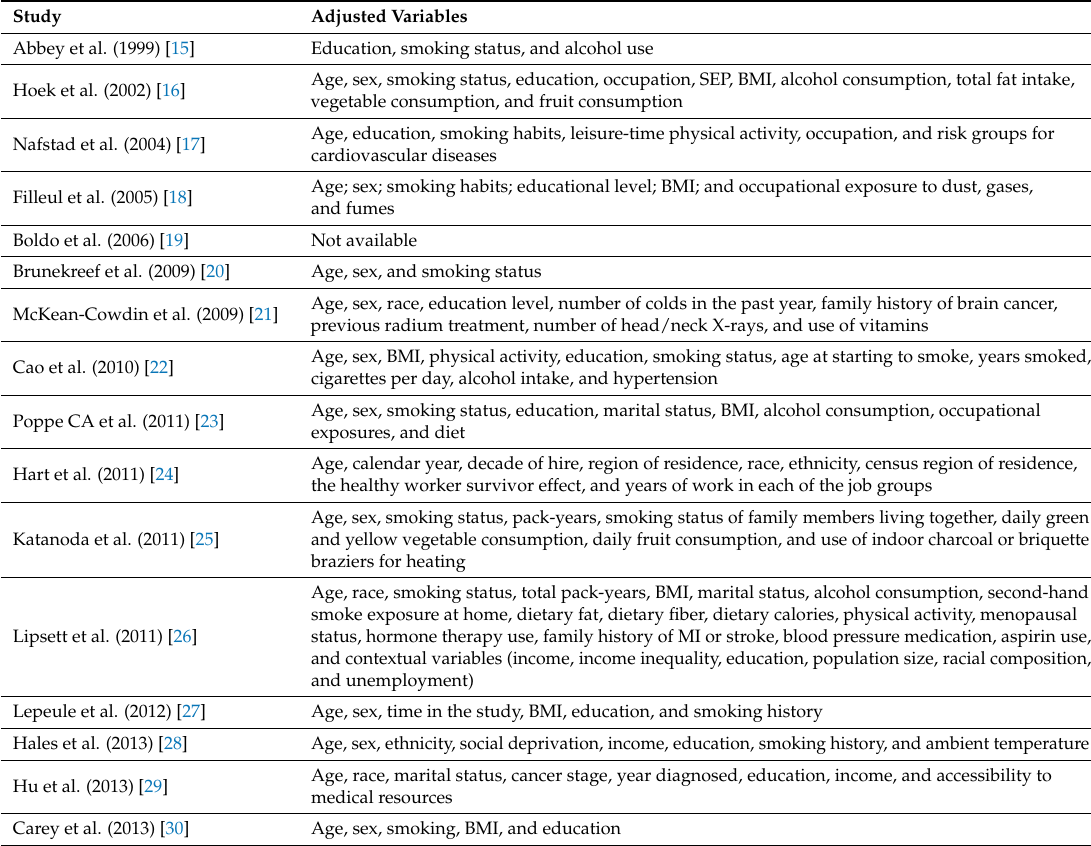
Table A1. Adjusted variables of each